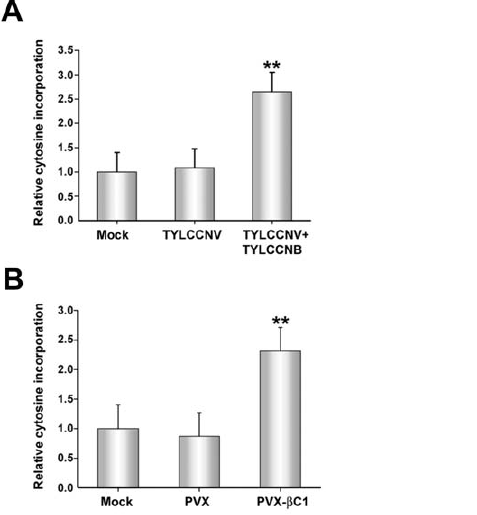
methylation profiles confirm that TYLCCNB inhibits methylation. Plants were inoculated, and viral DNA was obtained from symptomatic primary tissue, and recovered or non-recovered secondary tissue, as indicated. Methylation of the BCTV IR was assessed by bisulfite sequencing. The circles represent cytosines in the IR and are color coded according to sequence context (CG red, CHH green, CNG blue). Filled circles indicate methylation, and each line represents the sequence of an individual clone. Graphic representations of the same data, with percent methylated cytosines on the Y- axis, are shown to the right. Student’s t test was performed on total methylation values using individual clones as data points. Asterisks indicate significant differences between samples with and without TYLCCNB at . 95%